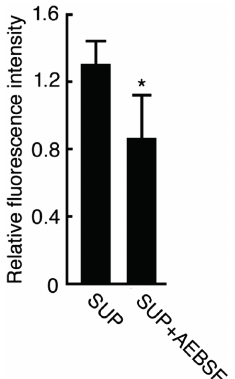
Figure 3. Detection of AEBSF-sensitive protease activities in the supernatant of the AR-induced sperm. AR was induced in 50 µg/mL DBA, and the supernatant (SUP) was treated with FTC (fluorescein thiocarbamoyl)-casein or co-treated with FTC-casein and AEBSF for 1 h. Sperm treated with 50 µg/mL DBA ( Dolichos biflorus agglutinin) and 10 mg/mL GalNAc ( N -acetylgalactosamine) were used as the control. Fluorescence intensities of those solutions were measured by a fluorometer. Relative fluorescence intensities were calculated by the ratio against the fluorescence intensity of the supernatant of the sperm whose acrosome reaction was inhibited by GalNAc. * p < 0.01 compared to the relative fluorescence intensity from FTC-casein reacted with supernatant of DBA-treated